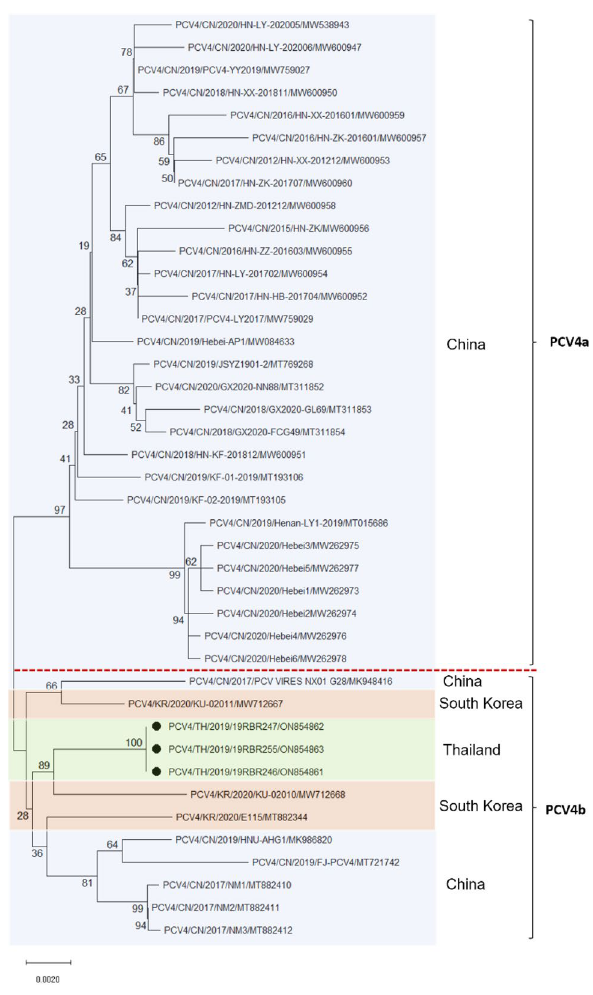
Figure 2. Phylogenetic tree based on the complete genome sequences of 3 Thai PCV4 strains and other reference strains. The Thai PCV4 sequences obtained in this study were marked with solid black circles. The colored background represented the country of origin of the PCV4 viruses. The phylogenetic tree was constructed using the neighboring-joining method with a p -distance model and bootstrapping at 1000